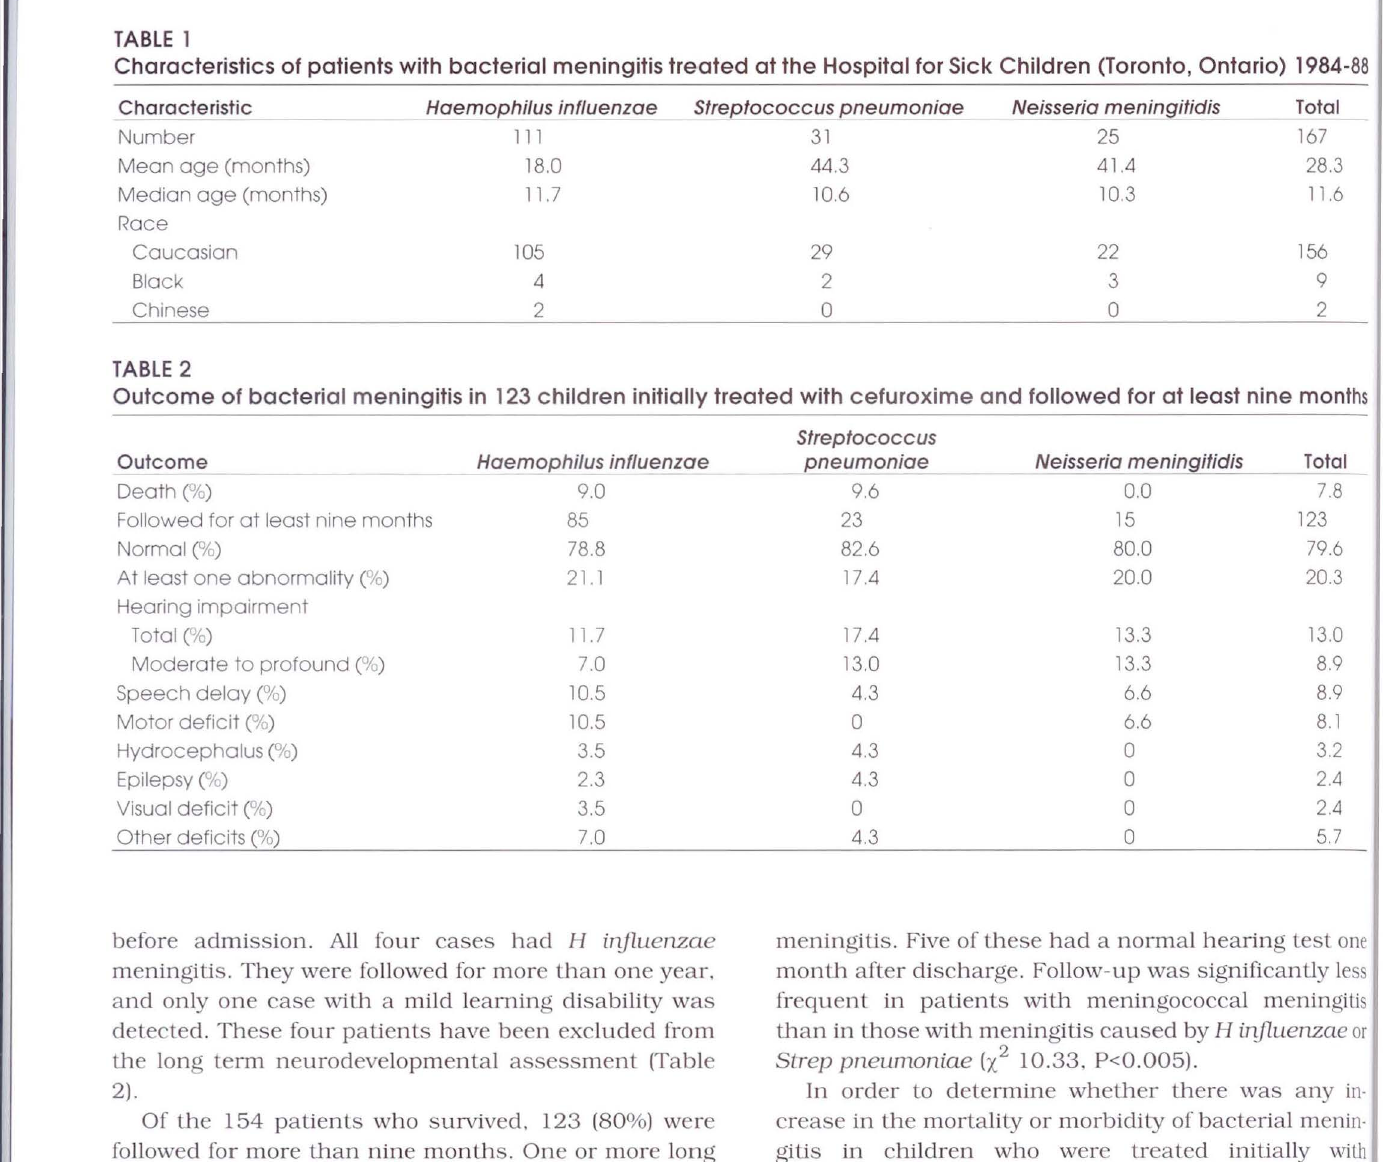
Characteristics of patients with bacterial meningitis treated at the Hospital for Sick Children (Toronto, Ontario) 1984-88